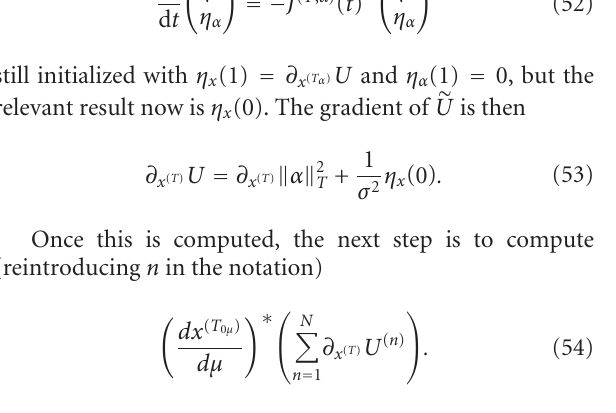
Algorithm 1 (MAE Step for Surface Template Estimation).